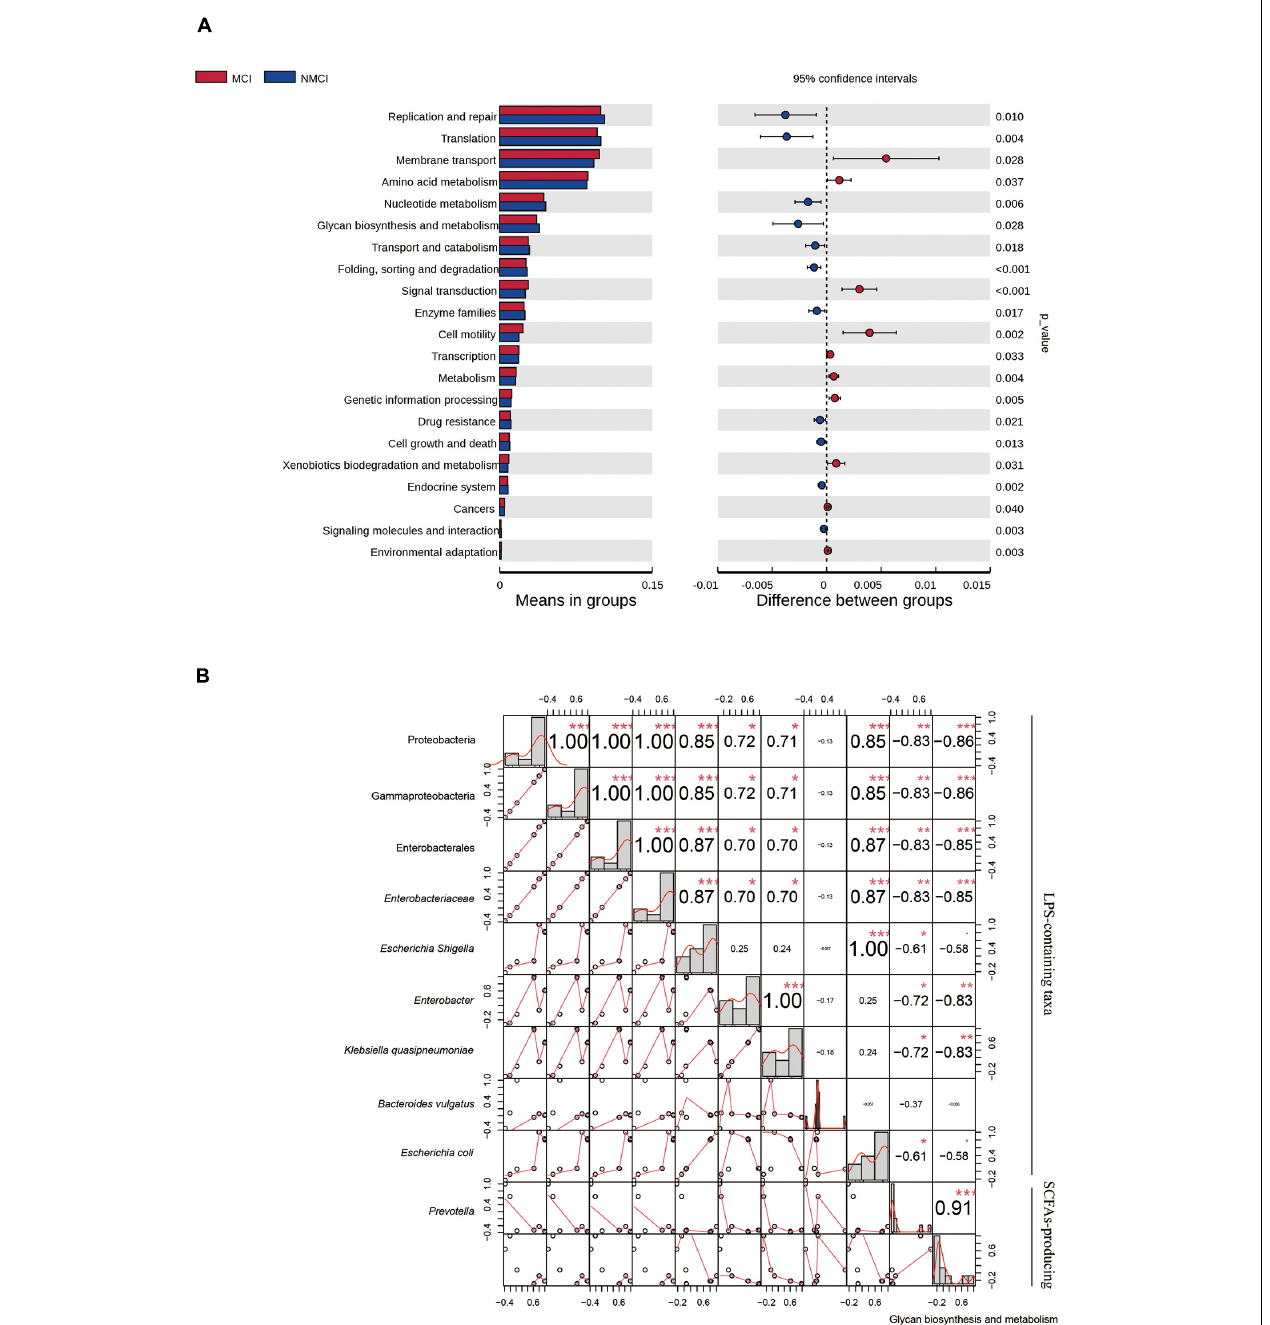
FIGURE 4 | Function prediction and correlation analysis. (A) Function predication was inferred by using Tax4Fun package of R software, and 24 KEGG-level-2 pathways were altered. (B) Pearson correlations among the glycan biosynthesis and metabolism pathway and distinct taxa. Numbers indicated correlation coefficients, and size of points reflected the strength of the correlation. * p < 0.05, ** p < 0.01, *** p < 0.001. MCI, hypertension patients with cognitive impairment; NMCI, hypertension patients without cognitive impairment; Control, health control subjects.